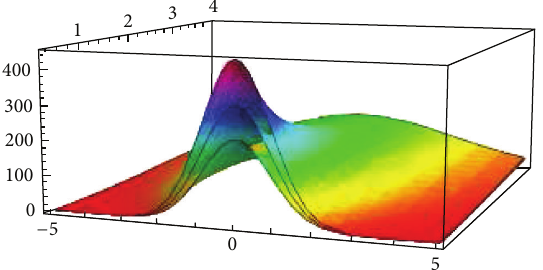
Figure 1: Graph of the fuzzy solution for 𝑎 = 𝑏 = 0 .